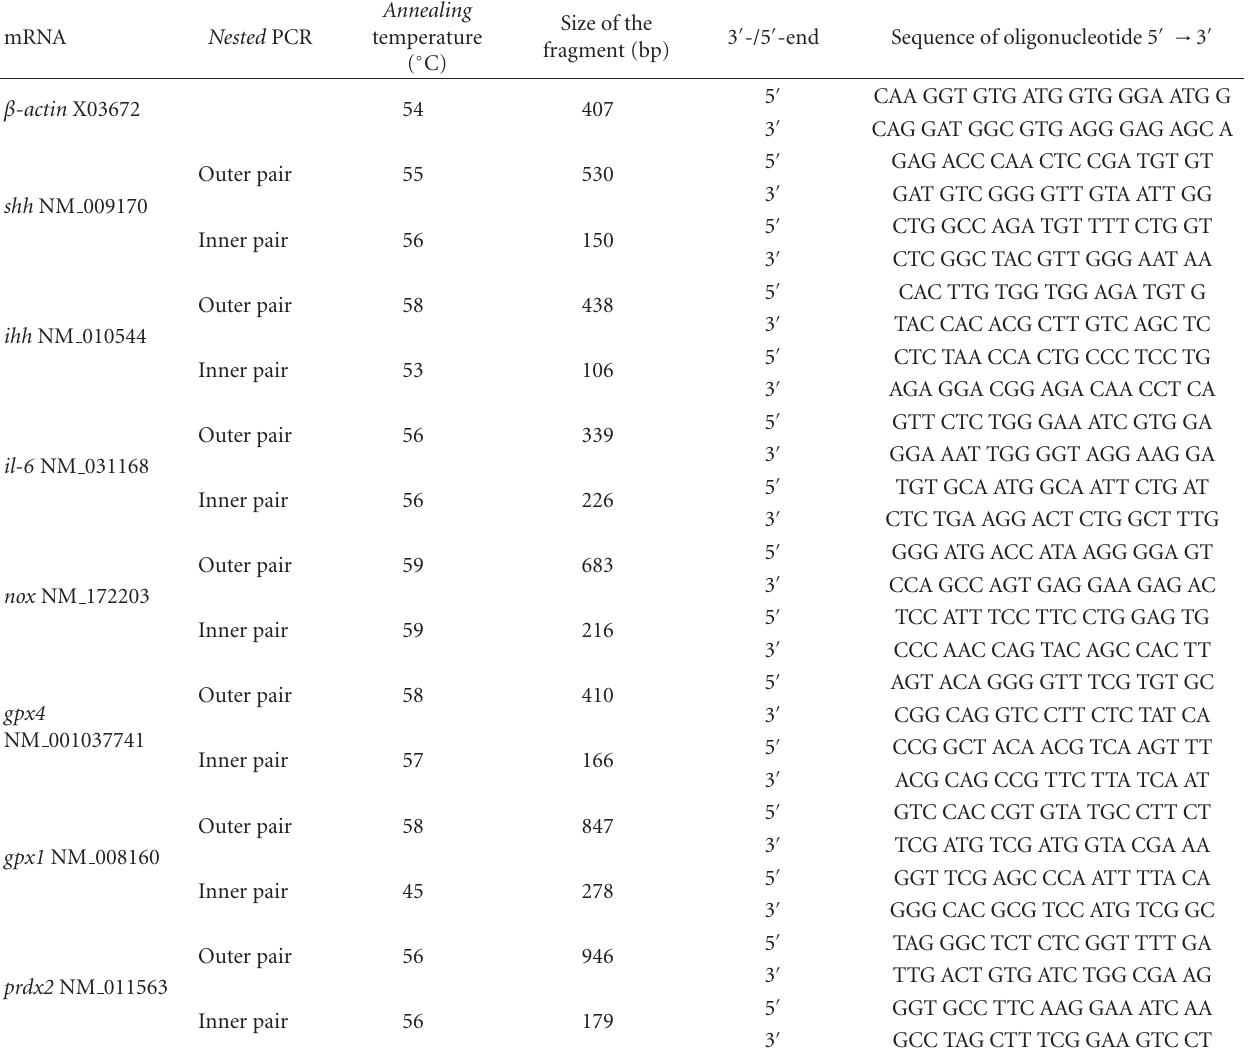
Sequence of oligonucleotide 5 (cid:3) → 3 (cid:3)